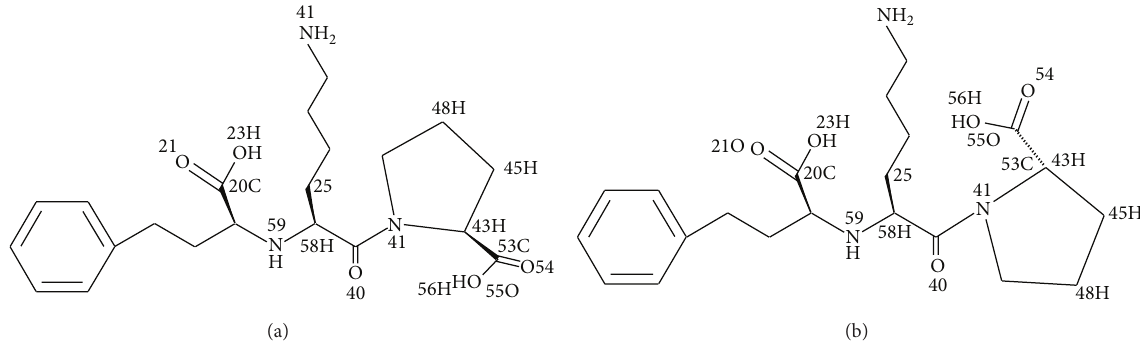
Figure 3: Chemical structure of lisinopril (S, S, S): (a) cis form and (b) trans form.